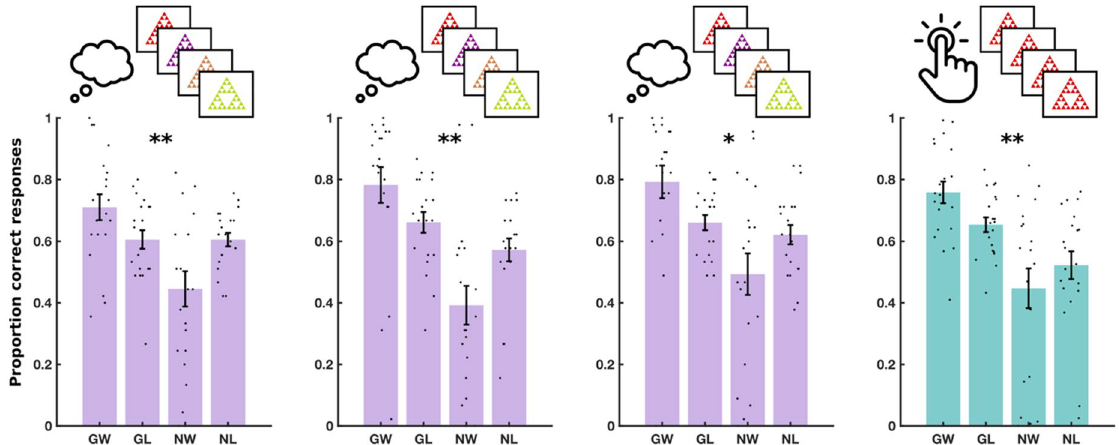
Figure 7. Experiment 5 results. Performance in three daily training sessions of SS g− and a fourth testing session of MM on day 3. Each dot shows the average performance for an individual subject in one of the four conditions: Go to win (GW), go to avoid losing (GA), no-go to win (NW) and no-go to avoid losing (NL). Error bars show standard error of the mean across participants. Significance stars show P-value ranges for the interaction between valence (win/avoid losing) and choice (go/no-go) on performance. *P < 0.05. **P < 0.01.